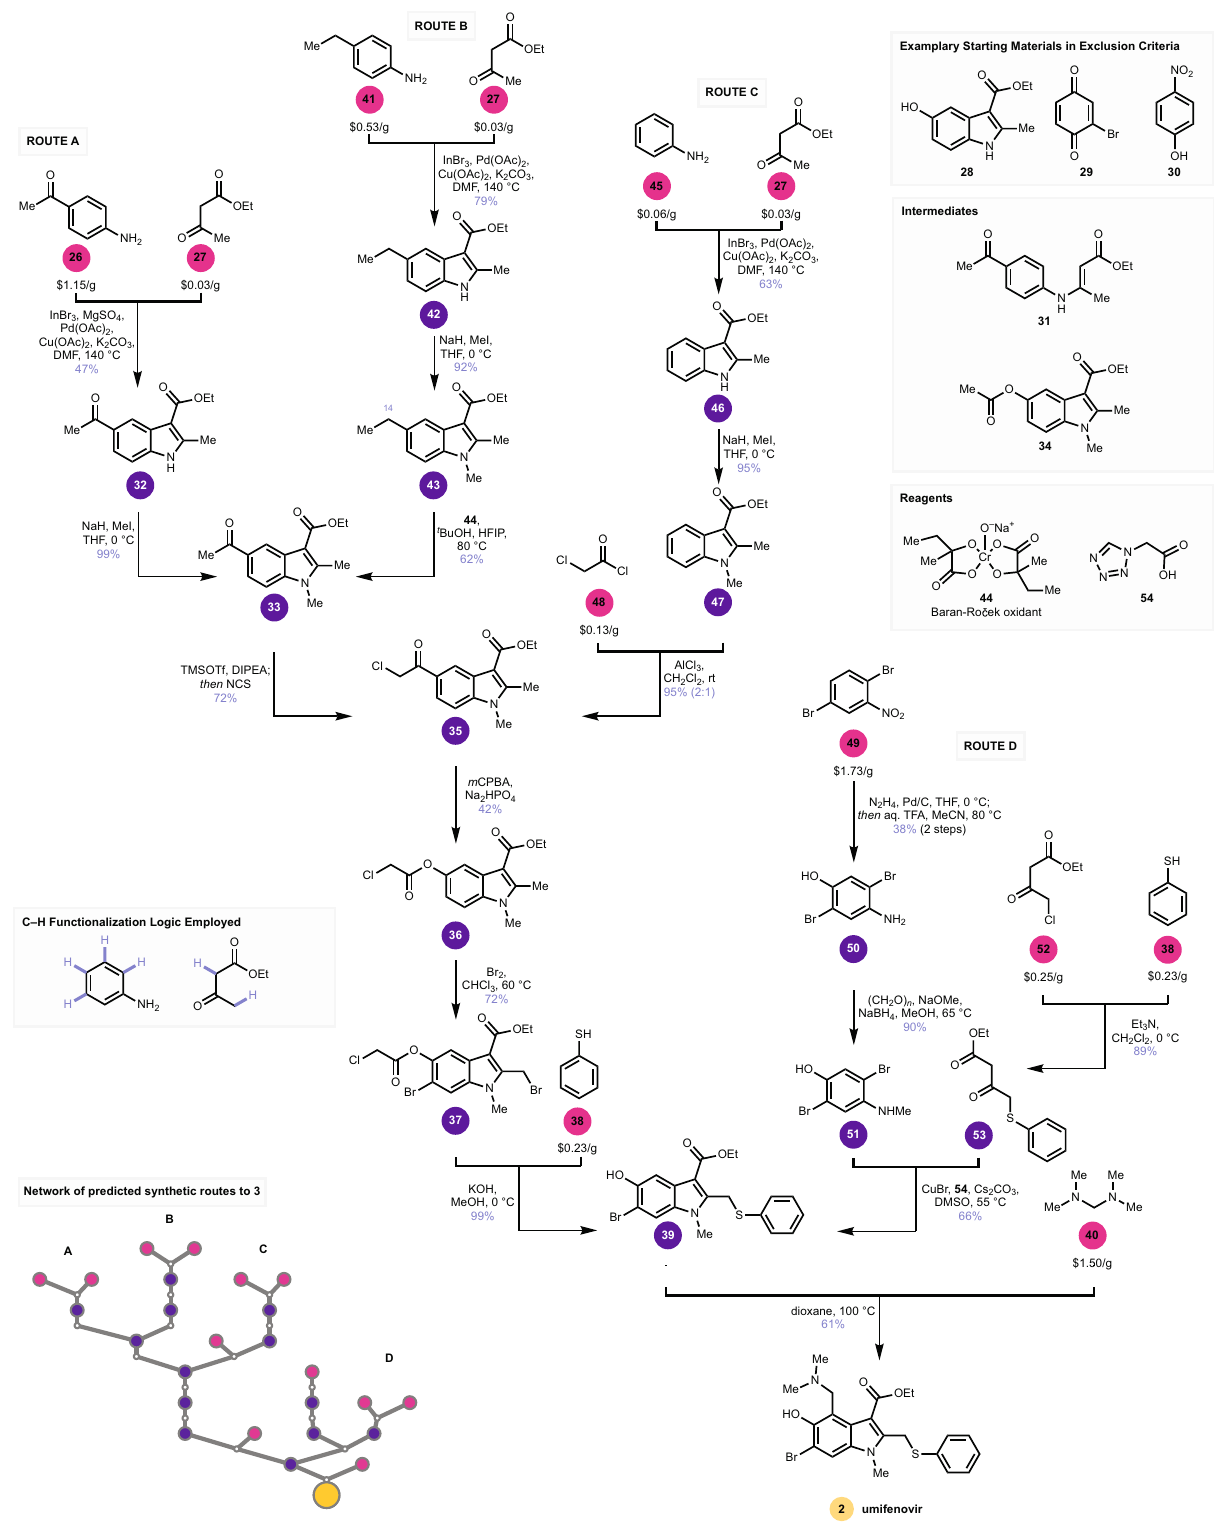
Fig. 4 Experimental demonstration of four routes to 2. Each route terminates in inexpensive starting materials. 26 , 41 , 45 , 48 , and 49 have not been used in a published synthesis of 2 . The conversion of 33 into 35 , and the use of starting material 49 , instead of 5-bromo-2-chloro-1-nitrobenzene, were manual modi fi cations to the software ’ s prediction. See main text for